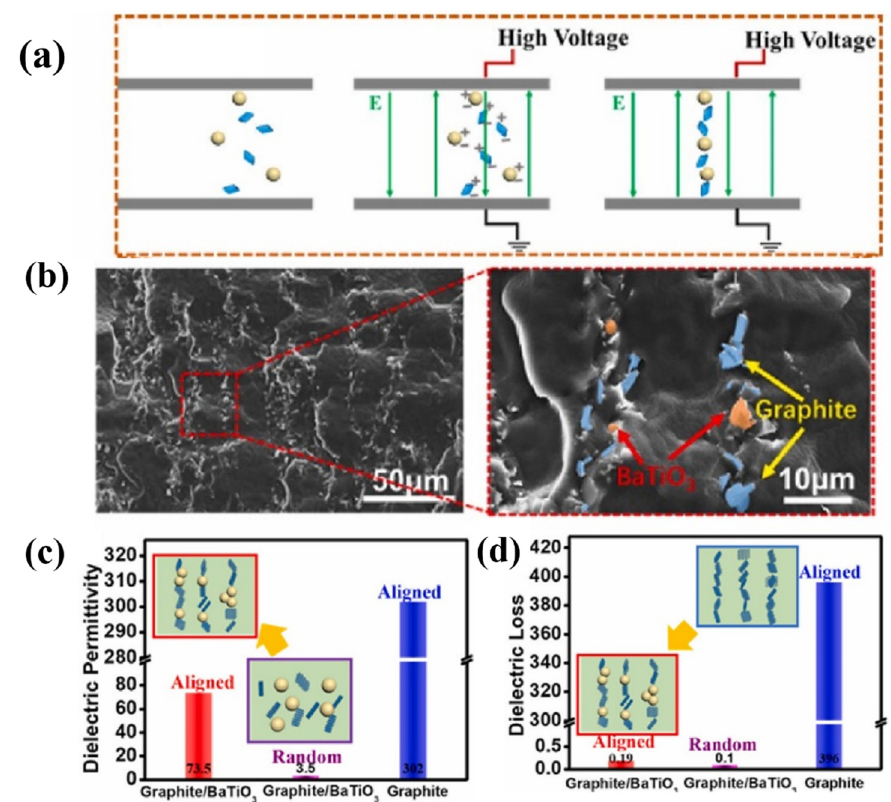
Figure 13. ( a ) A scheme of perparation of aligned copmposites. ( b ) Cross-sectional SEM images of the composites. Dielectric permittivity ( c ) and dielectric loss ( d ) of composite films. Adapted with permission [109]. Copyright 2021,